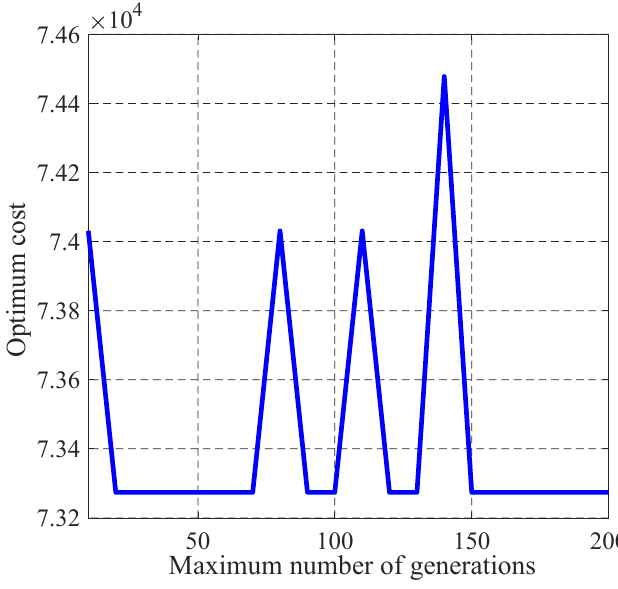
Figure 17. Variation of the optimum solution versus the maximum number of generations. (Robustness analysis case ‐ 2) In this case, The PGA ‐ MRFO algorithm is applied with a constant number of generations (50) while the population size varies from 10 to 200.